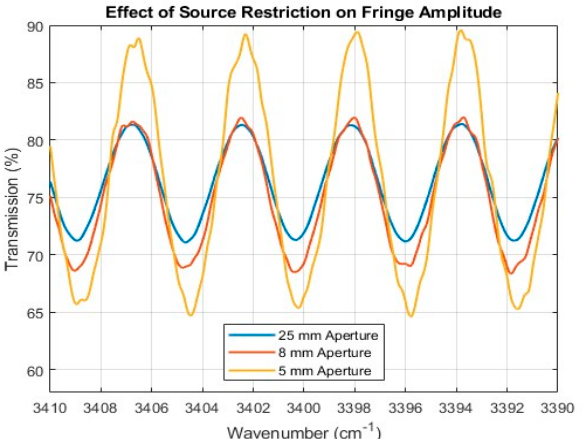
Figure 3. Reducing the aperture diameter, thereby reducing the maximum angle of incidence, serves to amplify the magnitude of the interference fringes.